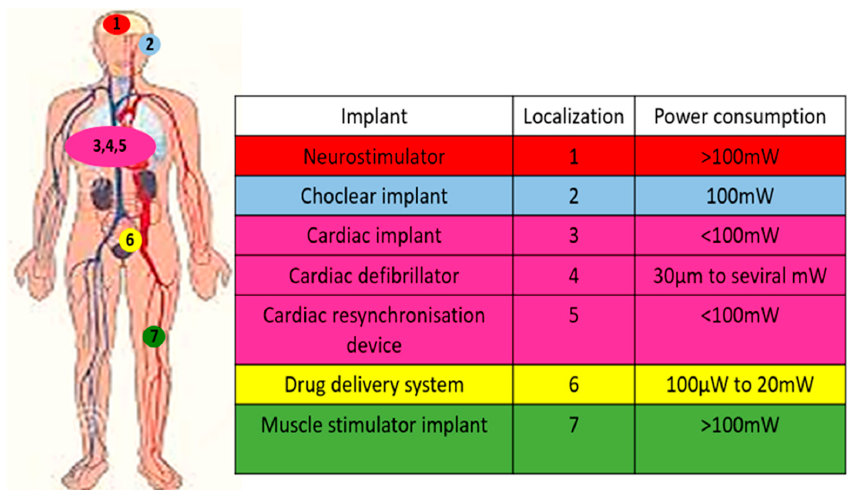
Figure 1. Localization of active implants in the human body and their power consumption.